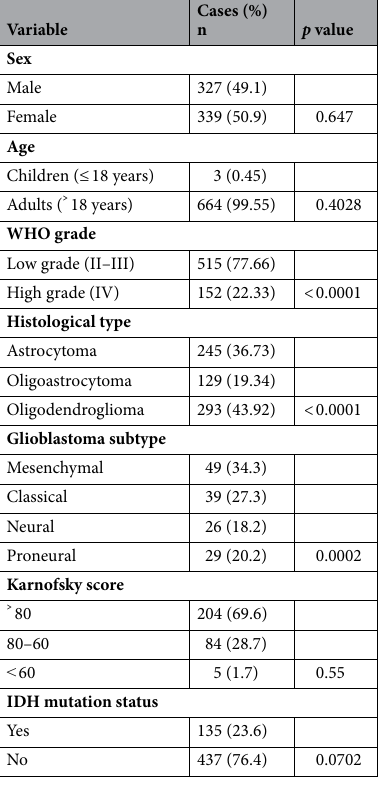
Table 2. Expression of VISTA according to the characteristics of the glioma patient cohort of the TCGA